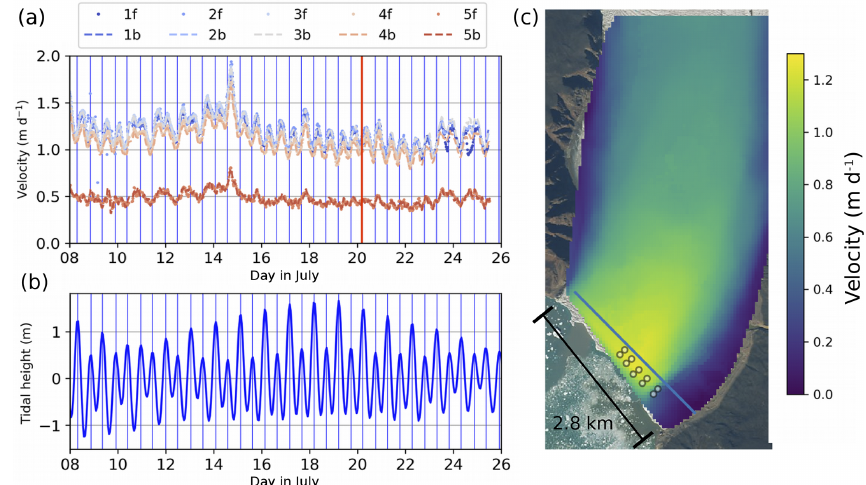
Figure 7. (a) GPS-derived horizontal velocity (4h moving average), (b) tidal height time series, and (c) Sentinel-2-derived horizontal velocity by averaging monthly velocities from 12 March–28 September 2019. Positions of the GPS in (a) are shown as white dots in (c) ; for labels see Fig. 3c. Blue vertical lines in (a) and (b) show the timing of high tide and the red vertical line in (a) the large-scale calving event on 20 July. The blue bar in (c) shows the flux gate used for ice discharge